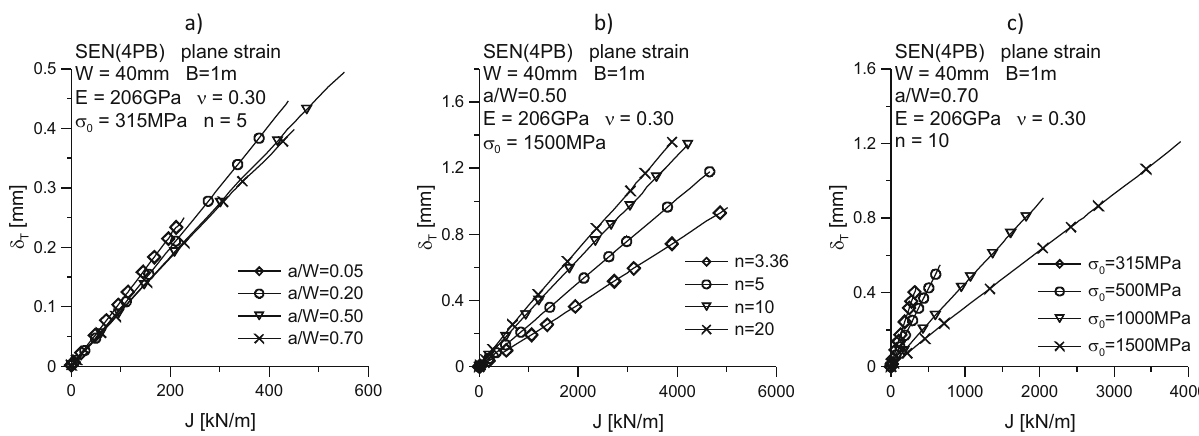
Figure 10: In fl uence of the relative crack length a / W ( a ) , the strain hardening exponent n ( b ) , and the yield point σ 0 ( c ) on the value of the crack tip opening displacement δ T determined on the basis of numerical calculations and the Shih method [ 16 ] as a function of the J integral.